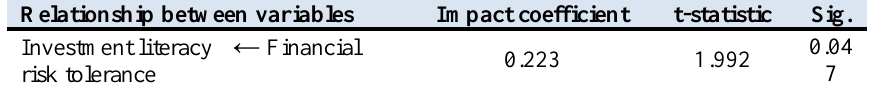
Table 6. Estimation of the coefficients of the third hypothesis